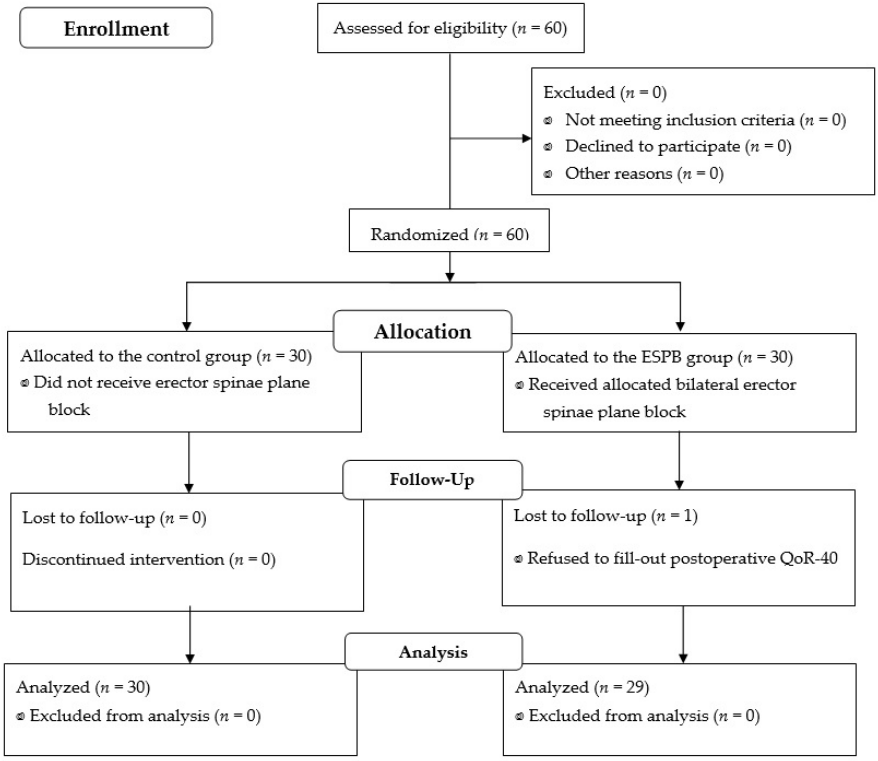
Figure 1. Flow diagram of patient’s allocation.